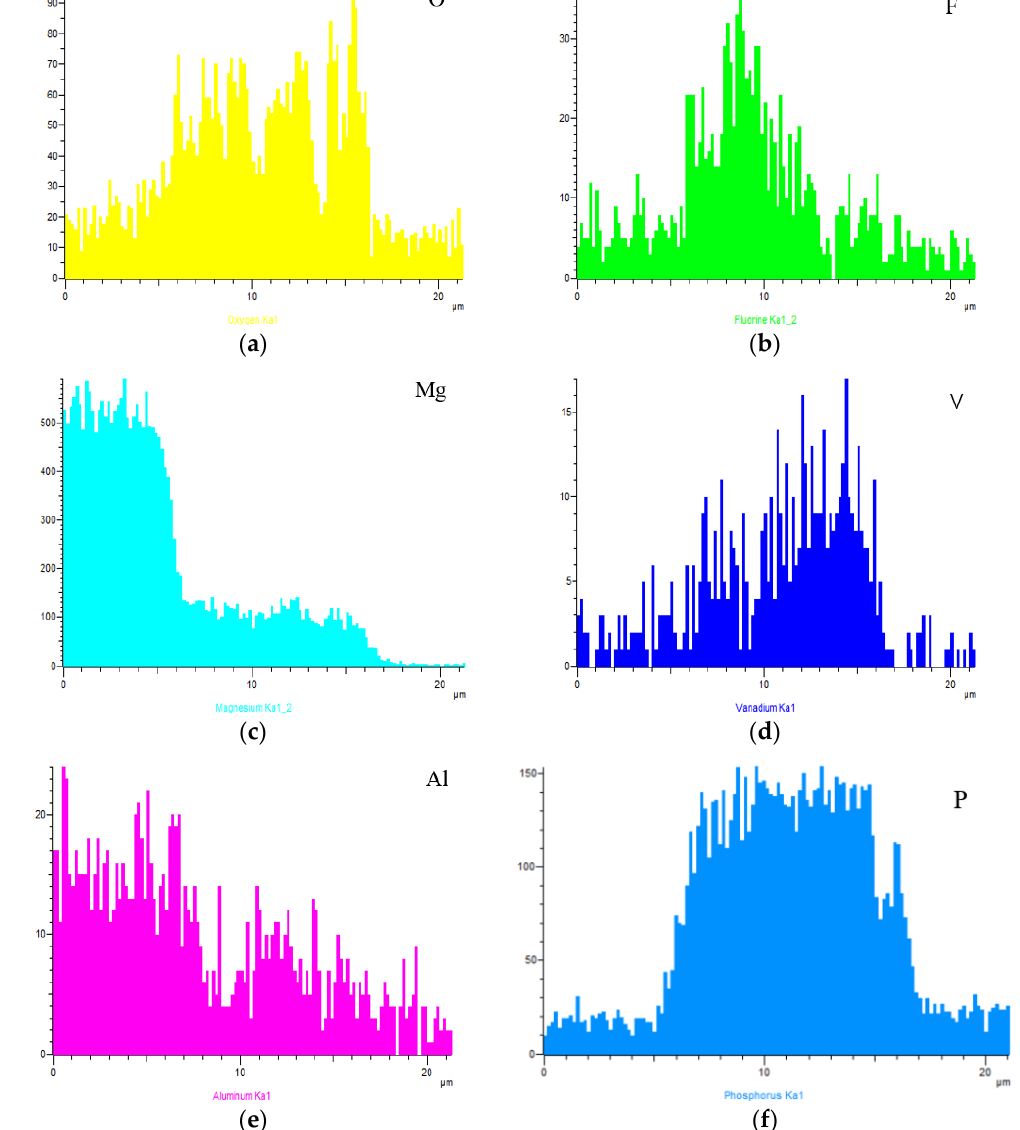
Figure 8. Element distributions of ( a ) O, ( b ) F, ( c ) Mg, ( d ) V, ( e ) Al and ( f ) P by line scanning along the arrow shown in Figure 7.